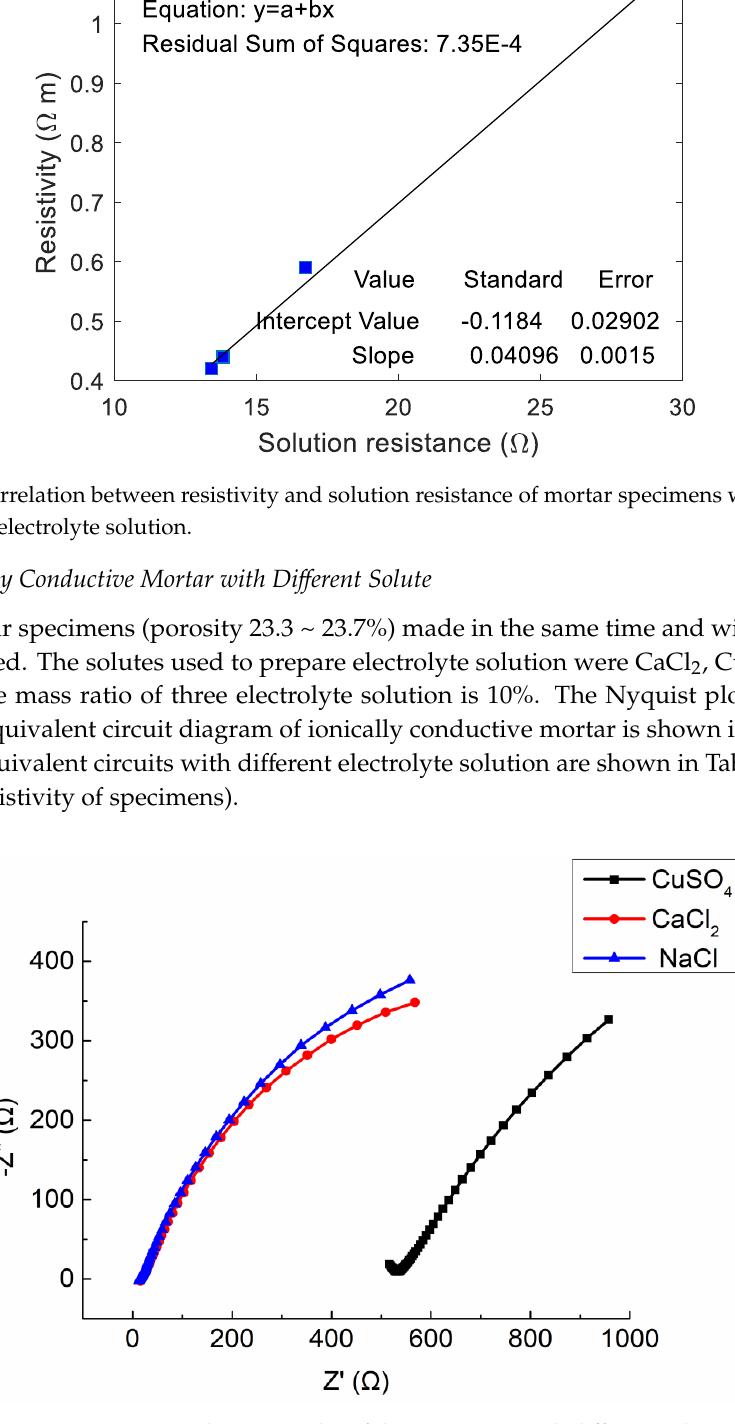
Figure 15. Integrated Nyquist plot of the specimens with different solute. Table 10. Parameters of equivalent circuit and resistivity of the specimens with different solute.